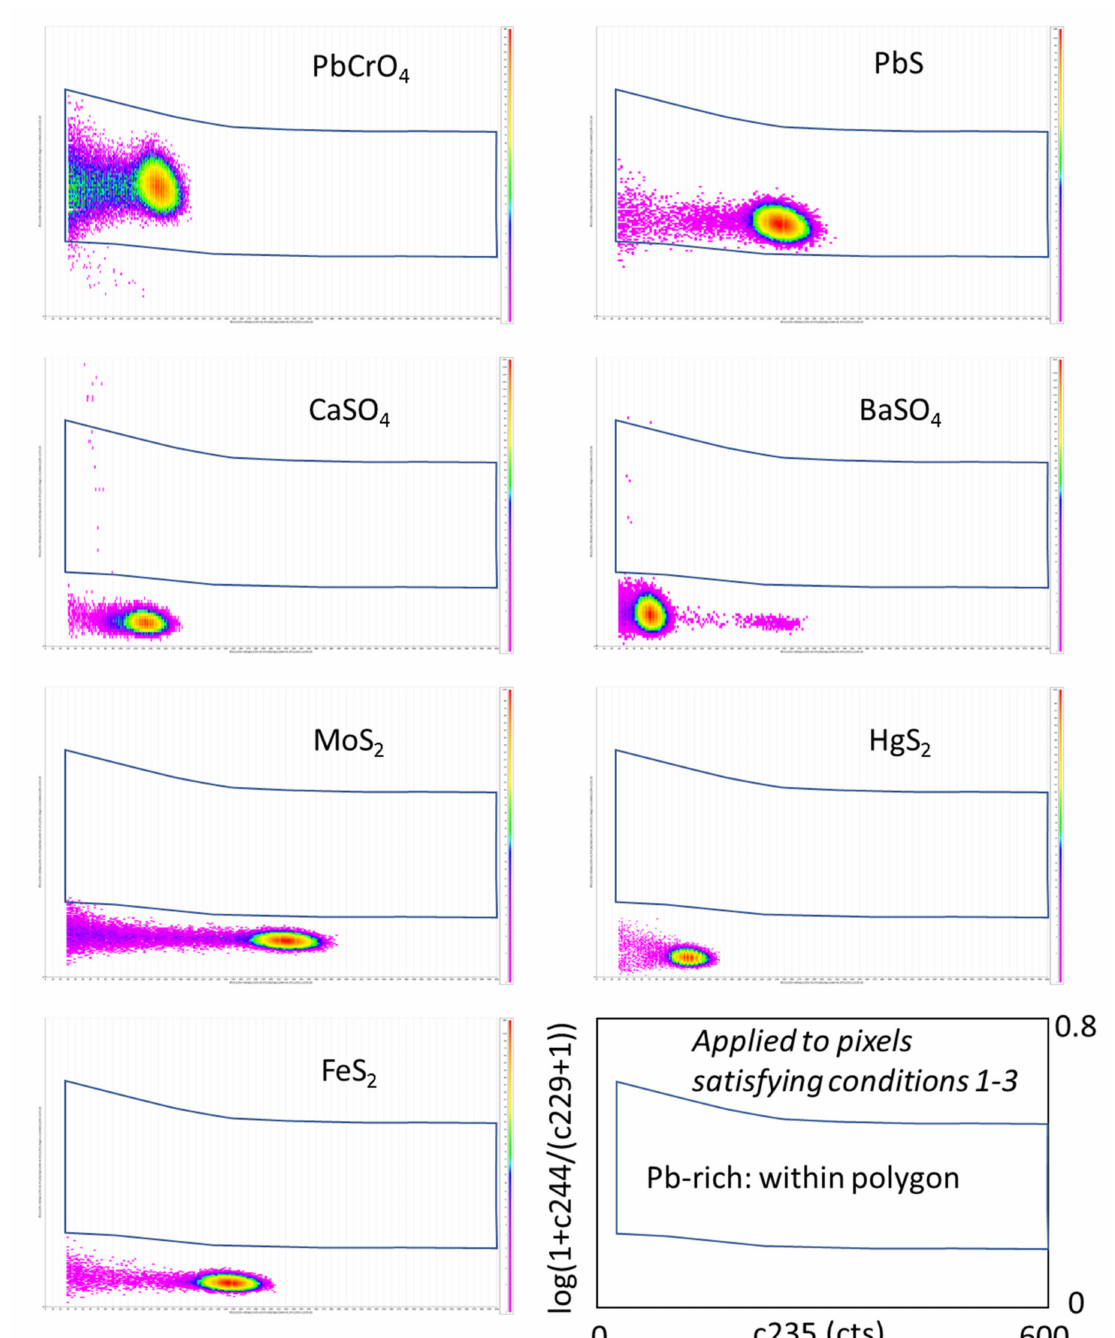
Figure 4. A 2D-density plot definition of Pb-rich PARC group based on analyses of standard reference phases in polished section, as shown. Axis definitions and ranges shown in lower-right plot. c229, c235 and c244 denote raw channel intensities (counts) corresponding with energies 2.29, 2.35 and 2.44 keV, respectively, in the spectra of individual SI pixels. The density of points (pixels) for a given x-y bin is indicated by the marker colour (magenta = lowest; red = highest density). For a given dataset, all pixels satisfying conditions 1–3 are included in the density plot. Those plotting within the demarcated polygon are classified as belonging to the Pb-rich group. Those plotting outside the polygon are returned to the main population of pixels and classified according to their peak combination or any other density plot definitions. Condition 1: c235 > 30; condition 2: c235 > 0.5 × c262; condition 3: c244 > 0.3 × c125, where c125, c262 correspond with channel intensities (counts) at 1.25 (Mg-K α ) and 2.62 keV (Cl-K α